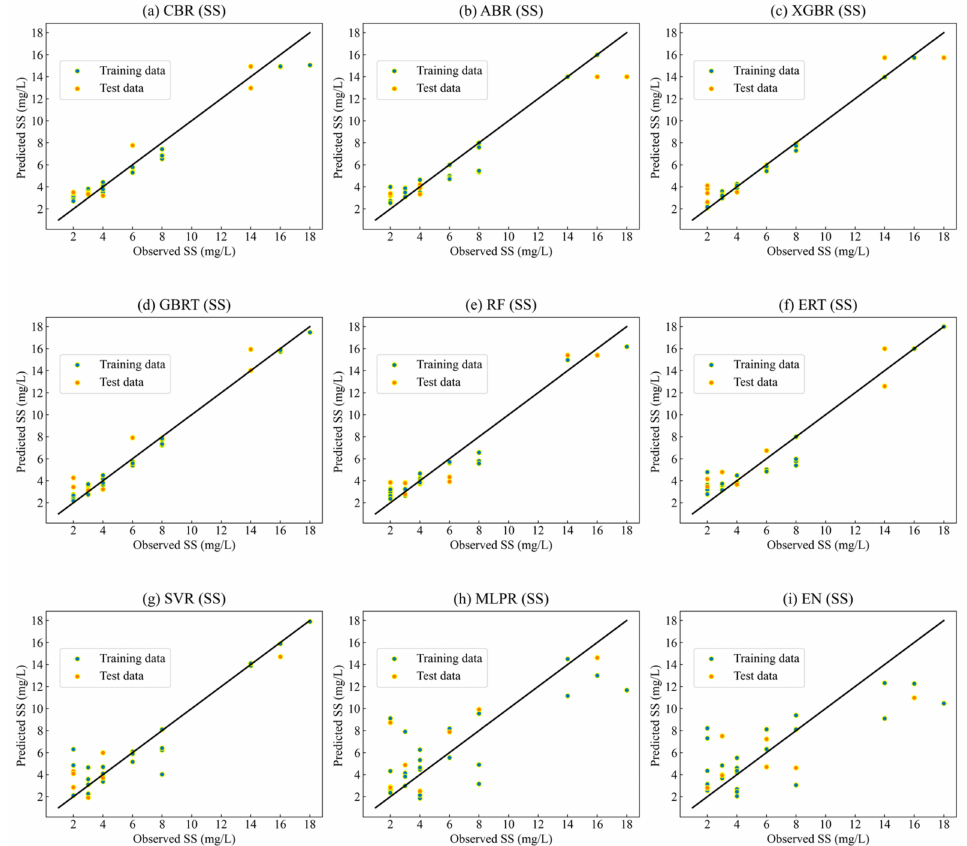
Figure 4. Scatter plot of the observed values and the predicted values of the SS (mg/L) concentration using nine machine learning models including CBR, ABR, XGBR, GBRT, RF, ERT, SVR, MLPR, and